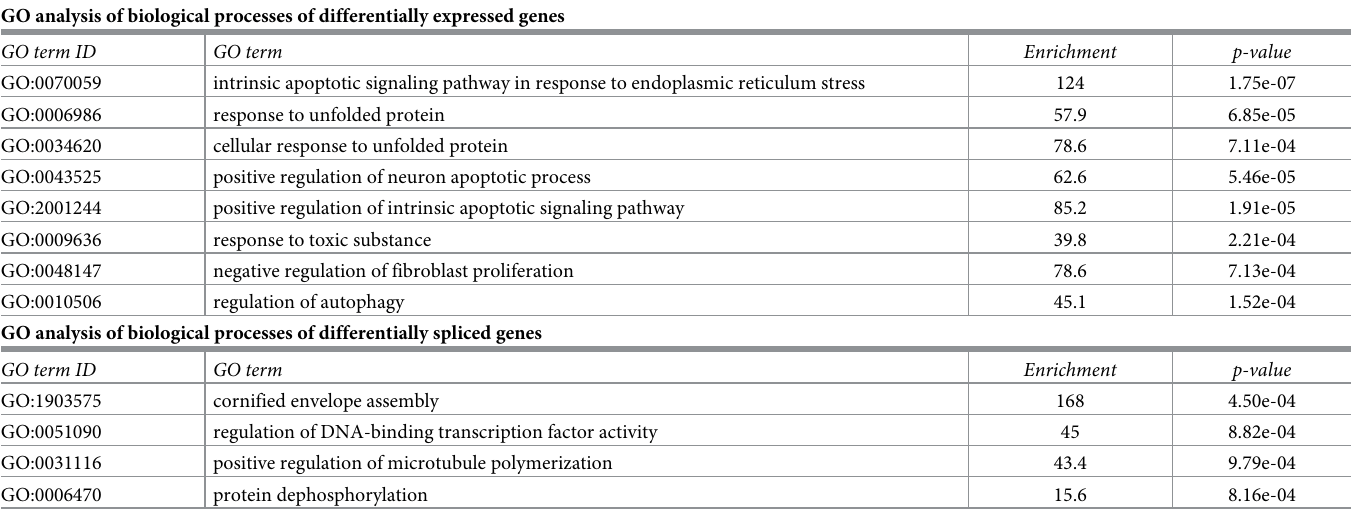
Table 1. GO analysis of differentially spliced and expressed genes after DHX38